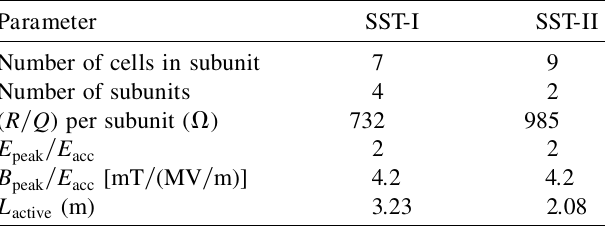
TABLE II. The rf parameters of both superstructures.